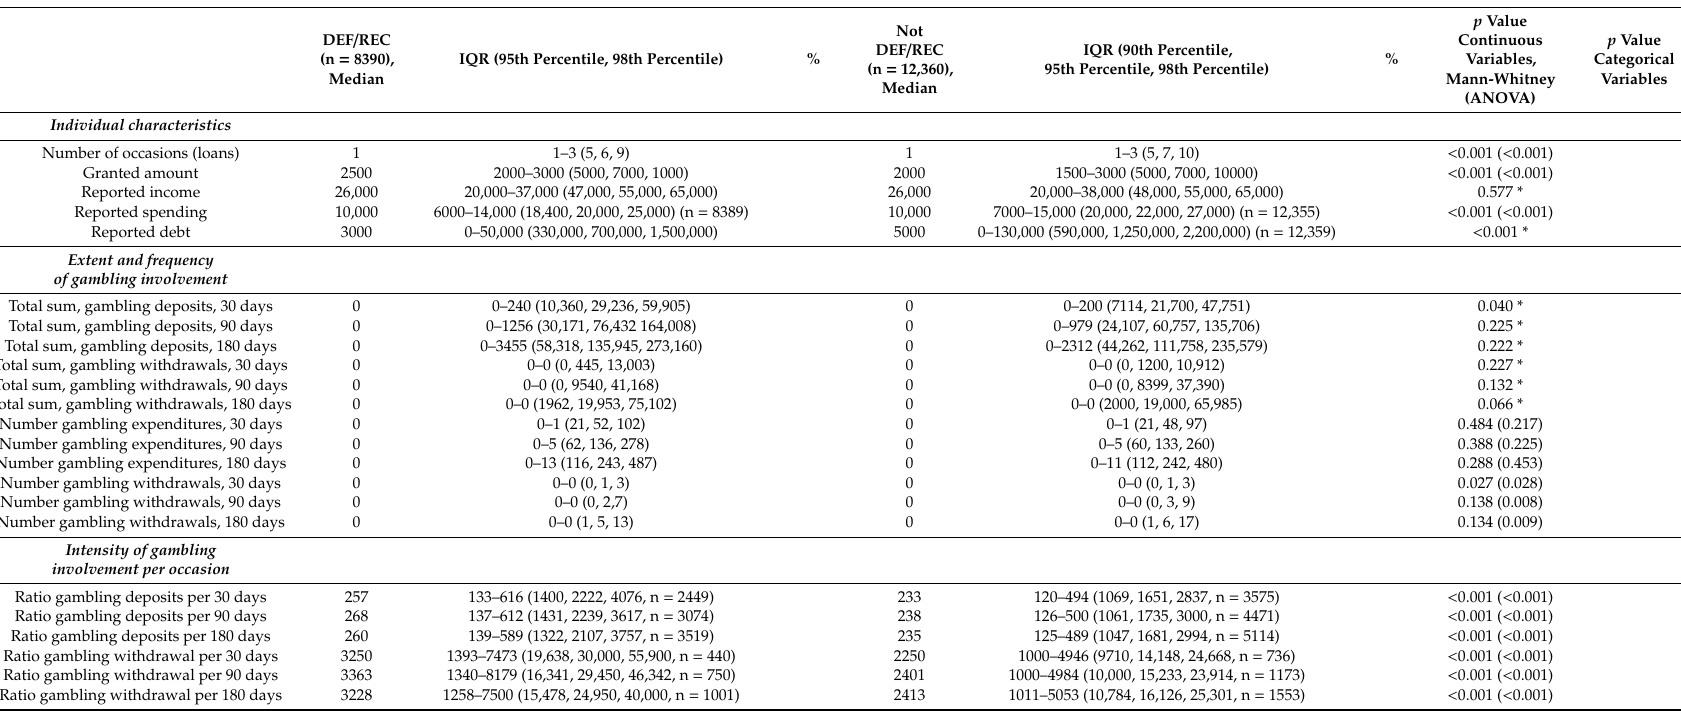
Table 3. Baseline correlates of an individual having a loan defaulted or defaulted / recovered (DEF / REC) on some occasion (primary loan or subsequent loans, N = 20,750). Comparisons made with Mann-Whitney U test (and one-way ANOVA) and chi-square tests for continuous and categorical variables, respectively. Numbers (n) in sub-analyses reported when other than the full